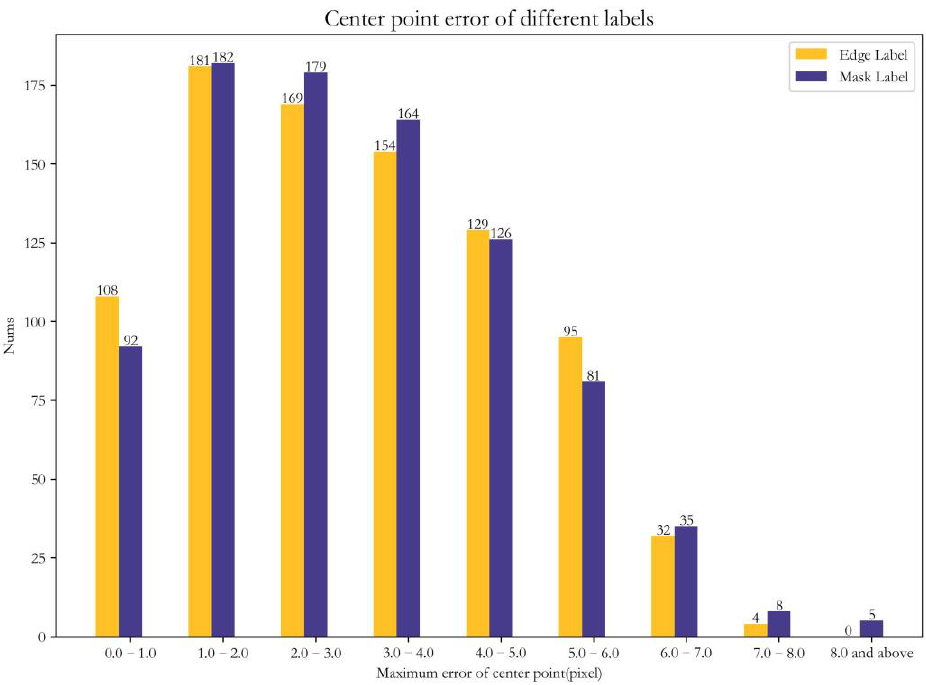
Figure 8. Statistical chart of center distance error for different labels.